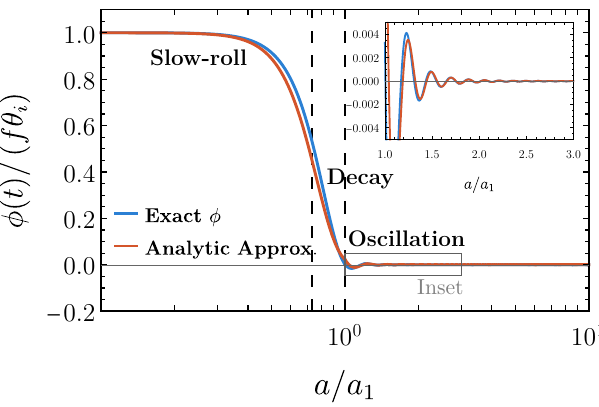
Figure 1 . Cosmological axion field evolution in the presence of sizable thermal friction. Blue is the numerical solution to the axion equation of motion, and Red is the approximate analytic solution given in eq. (2.9) and eq. (2.13). Here for the analytic solution, we take A ' 1 . 0 to get the best fit line. a represents the scale factor, and a 1 is its value at the time when axion field begins to oscillate. At the beginning of the oscillation, γ 1 /H 1 ' 19 which determines the suppression of the axion field due to thermal friction afterward (see eq. (2.13)). Before the oscillation, the axion field already moves substantially in the Hubble time in contrast to the conventional scenario of negligible thermal friction. For the parameter set in this figure, axion abundance coincides with the observed dark matter abundance: f h ' 2 . 7 × 10 6 GeV , ξ = 10 − 7 , f = 10 16 GeV , m φ = 0 . 1 eV , g ∗ ( T 1 ) = 106 . 75 , θ i = 1 and T 1 ' 2 TeV